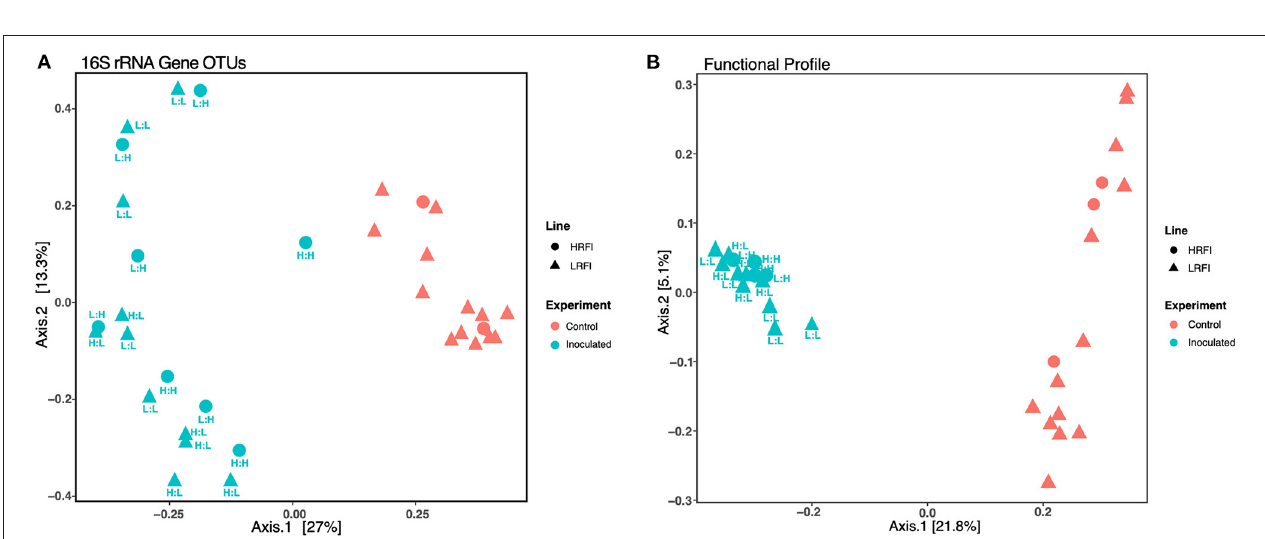
FIGURE 1 | Phenotypes of FMT-inoculated vs. uninoculated control chickens. (A) Average body weight for inoculated and uninoculated male and female bird groups over a 6-week period. Chicks received a single inoculum at day of hatch and were reared in identical conditions as described in the Methods section. Groups with letter M and F refer to male and female chicks. (B) Residual feed index (RFI, actual feed intake relative to expected; lower values represent increased efficiency) for each experimental group. Black horizontal bars depict the mean of all observations and blue horizontal bars depict the mean for birds sampled for metagenomic sequencing. Differences of means were significant by Kruskal-Wallis or student’s t -test as indicated on the figure.